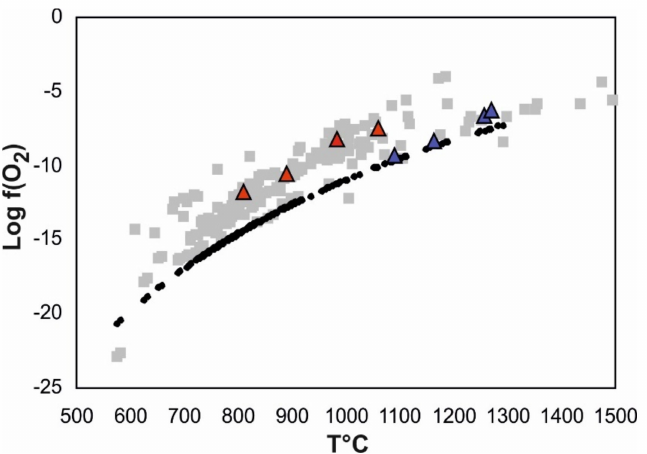
Figure 9. Variation in oxygen fugacity logf(O 2 ) as a function of temperature (T ◦ C) calculated for chromite–olivine inclusions from the Kraka chromite deposits of Prospect 33 (red triangle) and Bolshoi Bashart (blue triangle). Gray squares are chromite–olivine inclusion pairs from Ray–Iz and Kempirsai giant chromite deposits (data from [14]). The dashed line is the FMQ